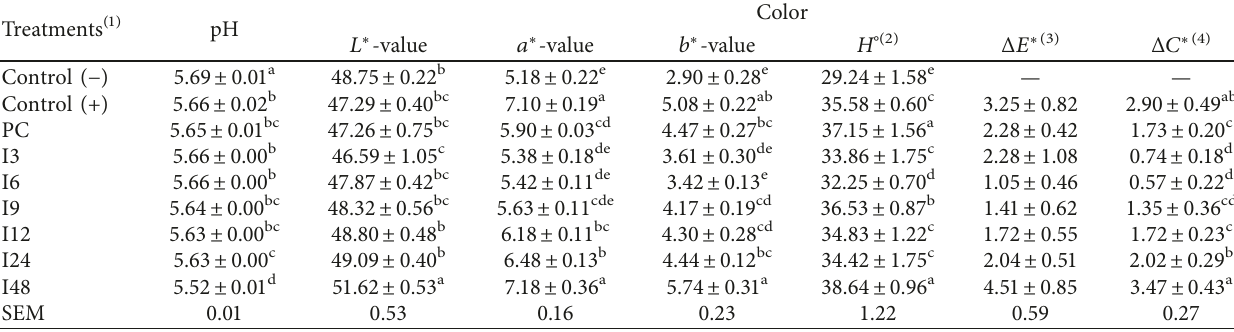
Table 1: Changes of pH and color of raw cured pork loin with spinach juice and different incubating periods. Color Treatments (1) pH L ∗ -value a ∗ -value b ∗ -value H ° (2) Δ E ∗ (3) Δ C ∗ (4) Control ( −